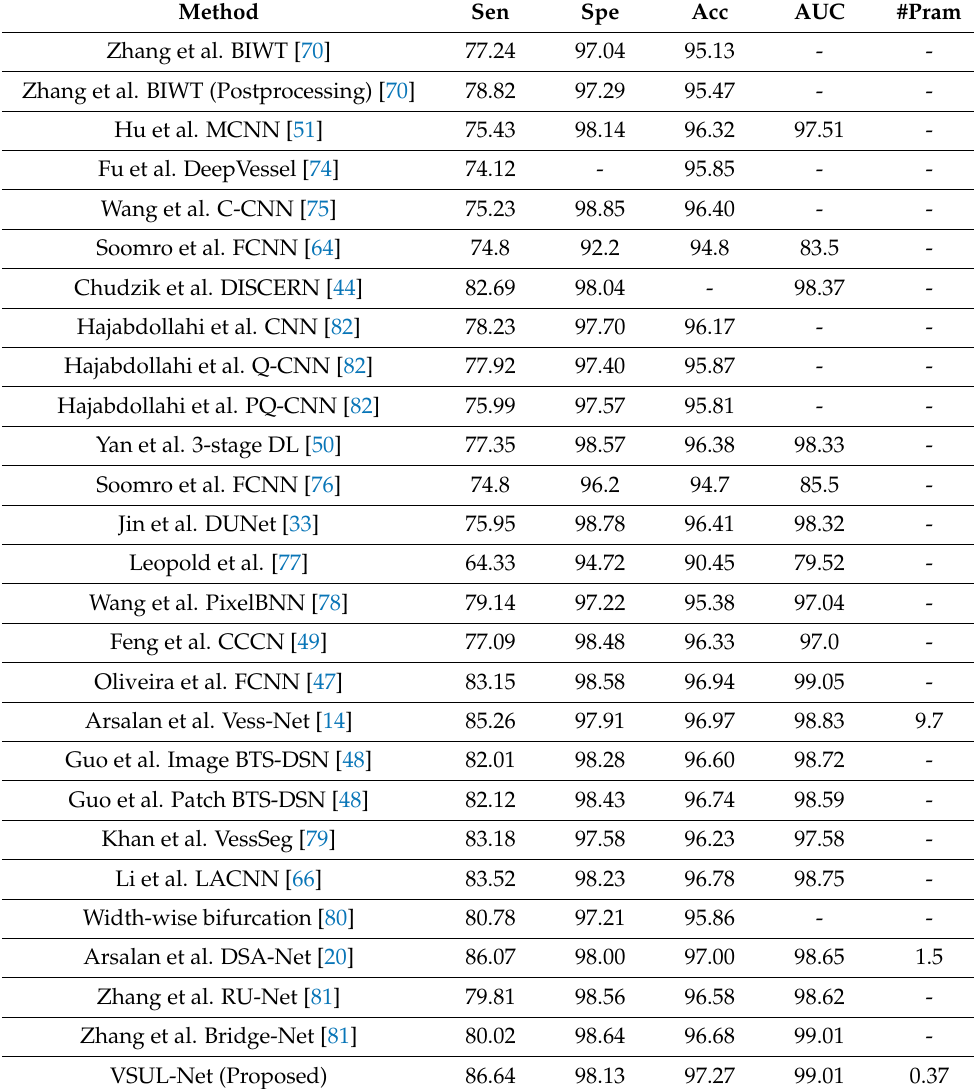
Numerical comparison of the proposed VSUL-Net with existing methods for the STARE dataset.